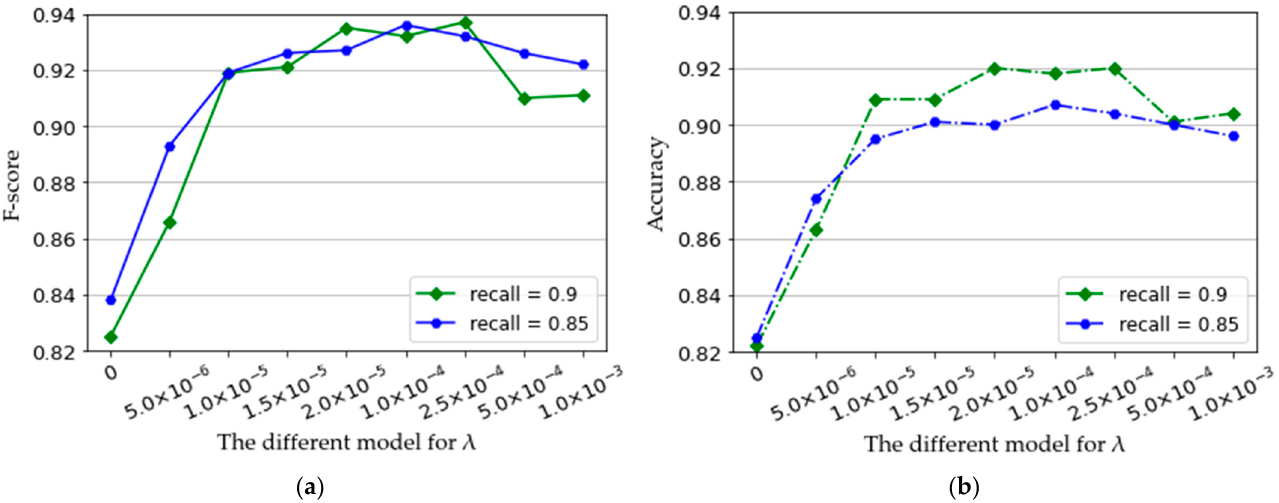
Figure 7. The mean F-score ( a ) and mean accuracy ( b ) of all subjects when the recall is defined as 0.85 and 0.9 , respectively, achieved by the trained models with different λ .